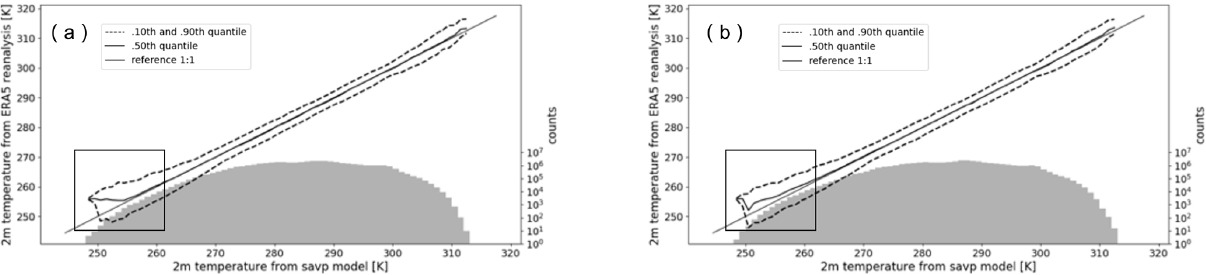
Figure 9. Conditional quantile plots in terms of the calibration-refinement factorization for 2m temperature forecasts with a lead time of 12h of the SAVP model with (a) λ 1 = 10000 and (b) λ 1 =